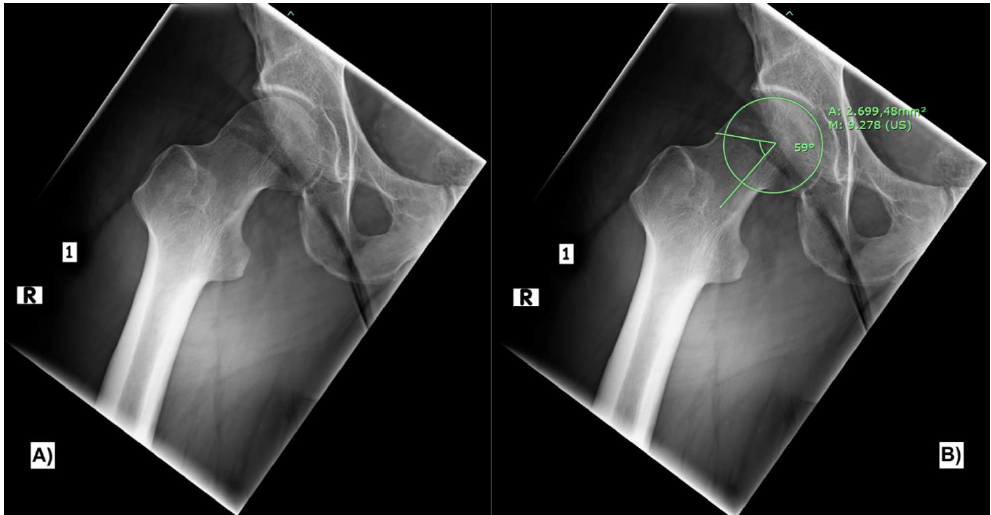
Figure 1. X-ray frog leg view of the right hip joint showing the CAM deformity ( A ). Measurement of the alpha angle ( B ).